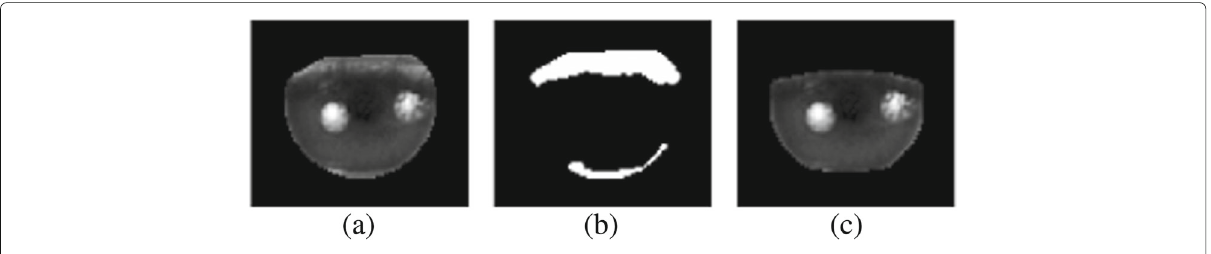
Fig. 6 Eyelids removal. Iris before eyelids removal ( a ), detected eyelids ( b ) and iris after eyelids removal ( c